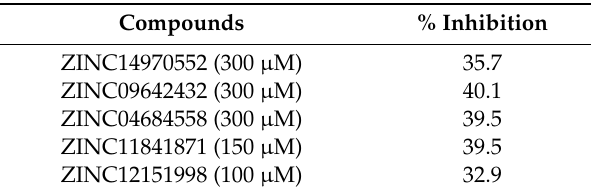
Table 2. Inhibition of rLmTR activity by selected